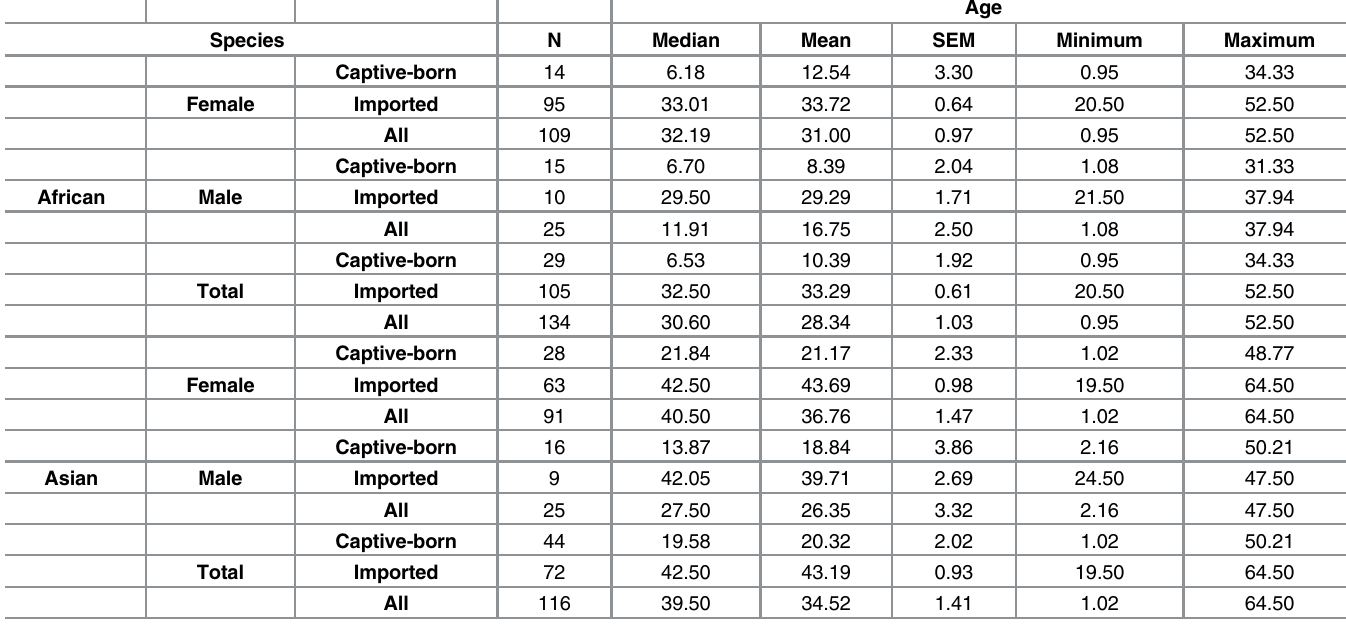
Table 1. Summary of population demographics including number of elephants (N) and age distributions (mean, median, SEM, minimum and maxi- mum) for each species by sex and origin.